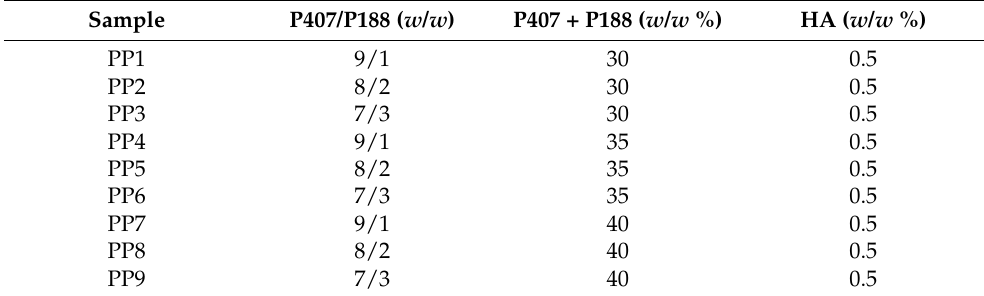
Table 2. Components in the formulation of P407-based hydrogel blended with different ratios of P188 ( w / w % in 10 g saline).